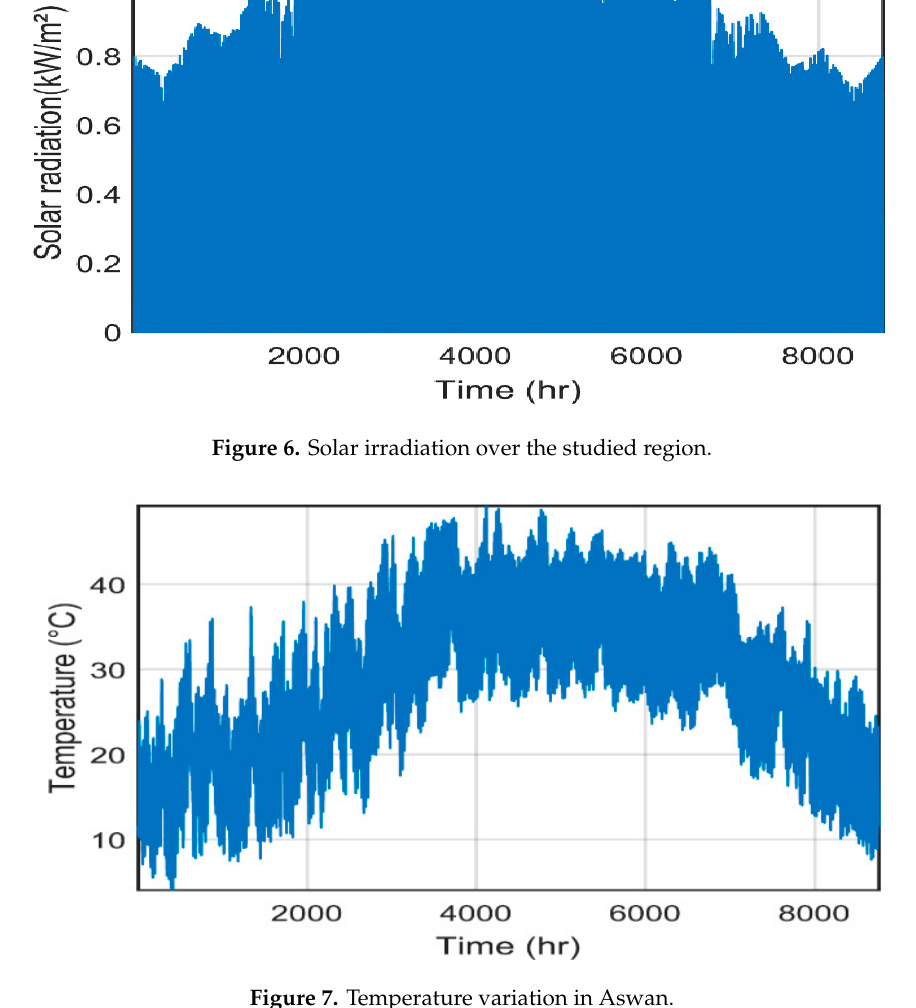
Figure 7. Temperature variation in Aswan.